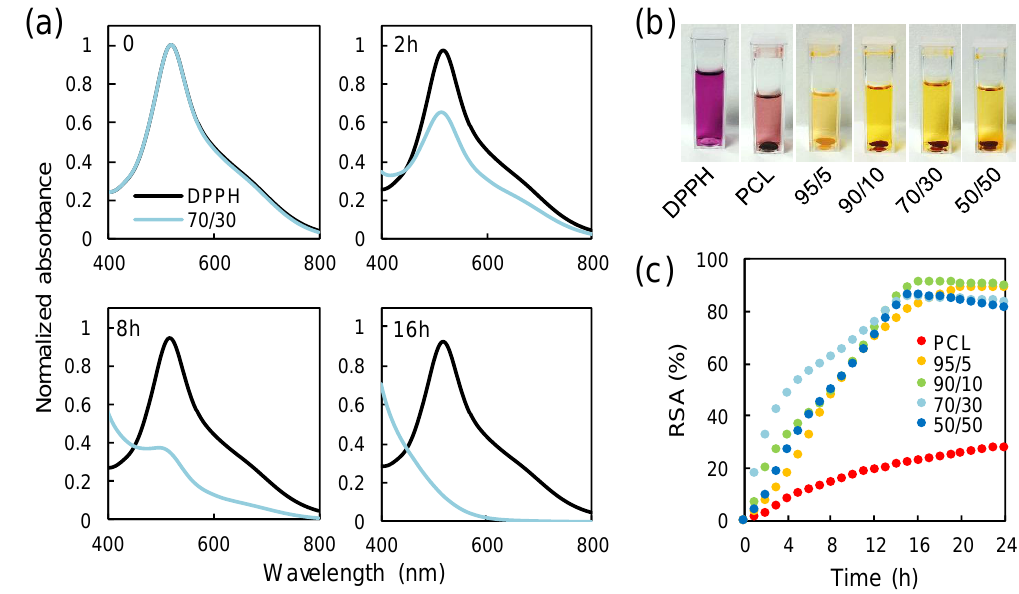
Figure 6. ( a ) Change in the absorption spectra upon reaction of 2,2-diphenyl-1-picrylhydrazyl (DPPH • ) with a 70 / 30 sample. ( b ) Loss of the characteristic deep violet color of the DPPH • solution after being in contact with di ff erent samples for 24 h. ( c ) Radical scavenging activity of PCL and PCL / PFA blends tested against DPPH • in a spectrophotometric assay.